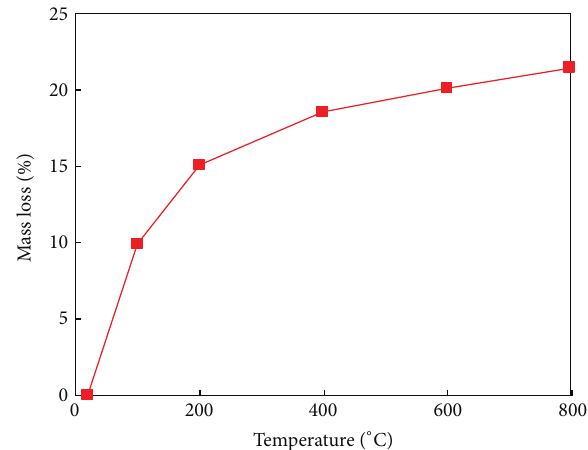
Figure 4: Mass loss of specimens of all curing ages with tempera-